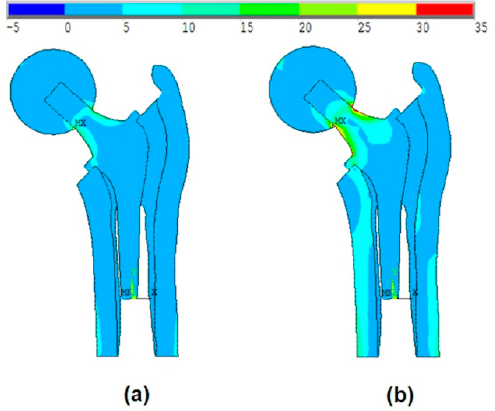
Figure 8. The effect of the introduction of the ball and bone anisotropy on the von-Mises stress distribution at ( a ) the mean point and ( b ) the MPP.